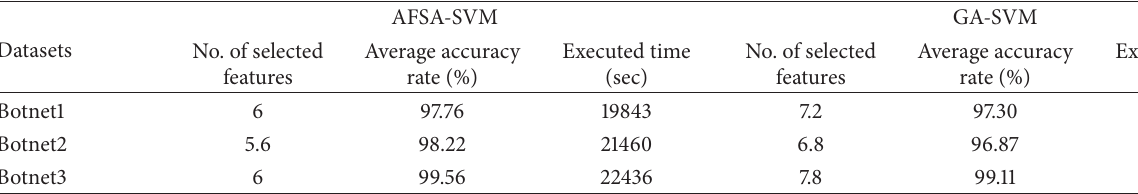
Table 4: The experimental results of AFSA and GA, 5-fold cross-validations.